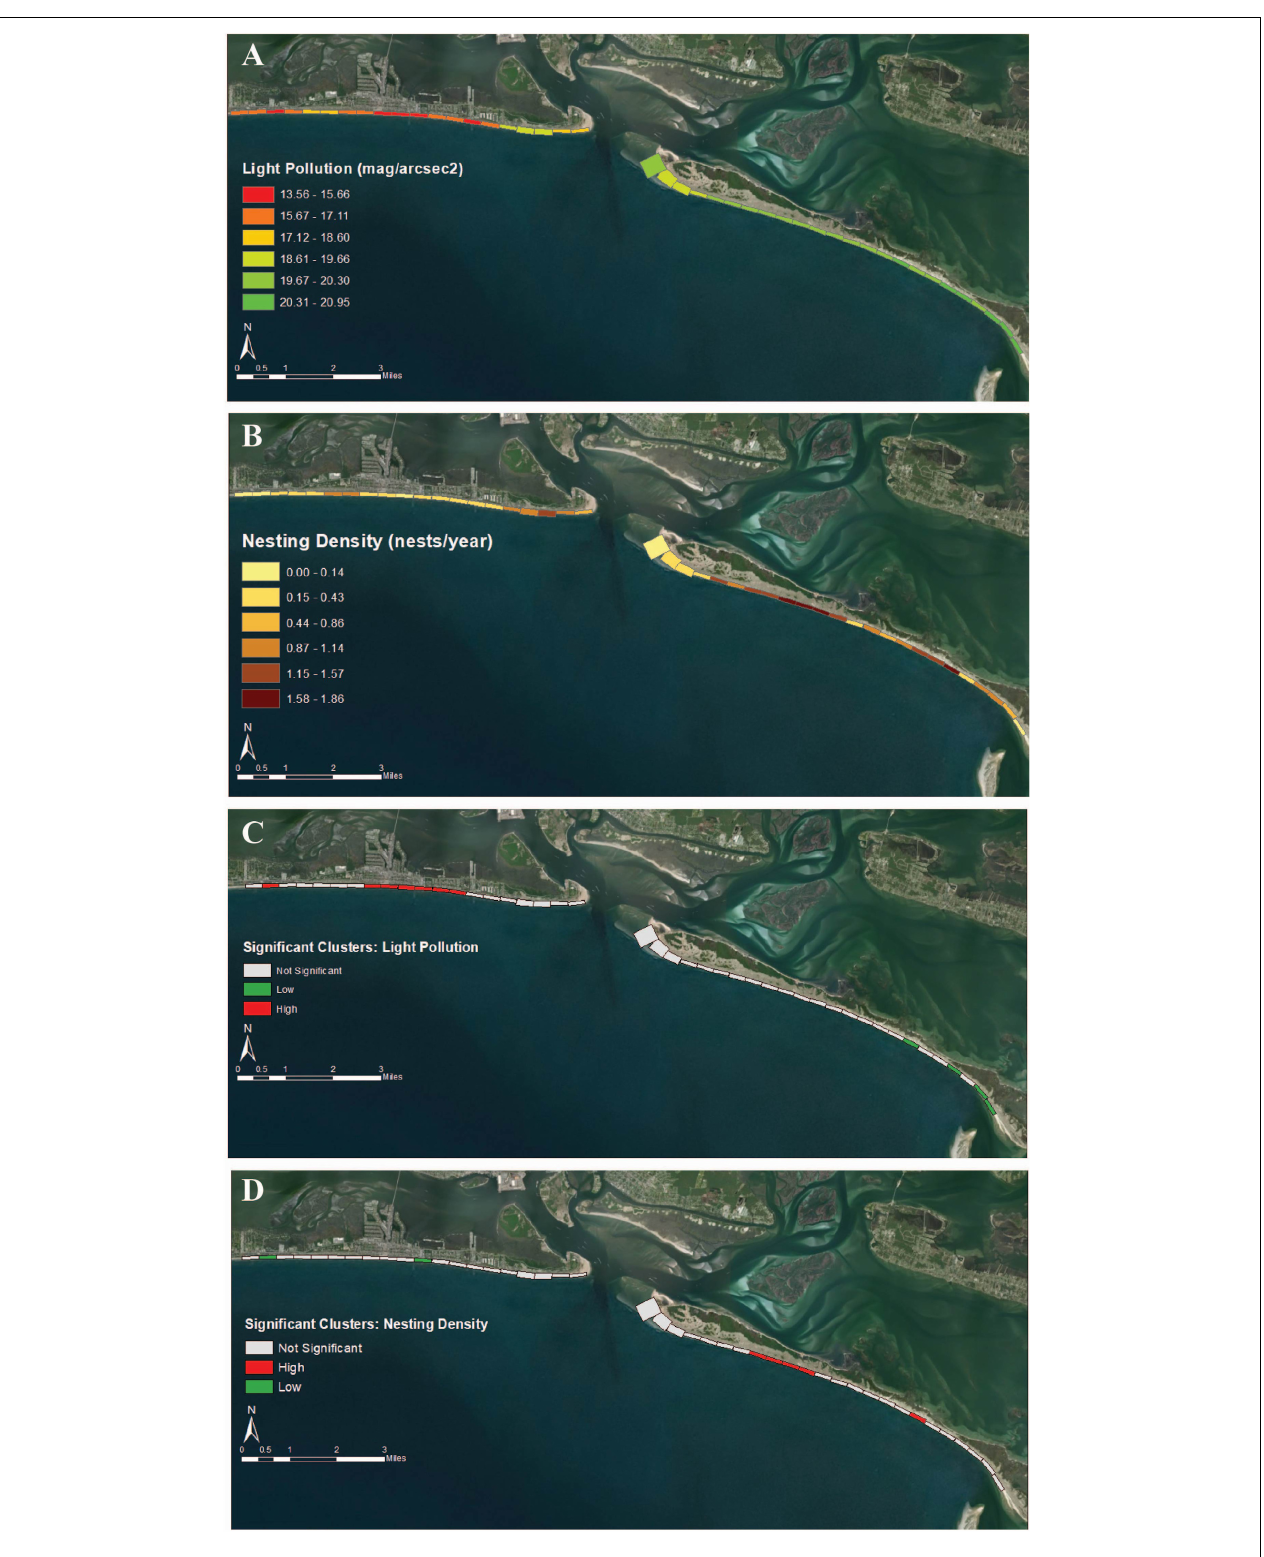
FIGURE 5 | (A) Mean light pollution value (mag/arcsec 2 ) in 500-m bins along study sites. (B) Nesting density (nests/year) from 2011 to 2017 in 500-m bin along study sites. (C) Cluster and Outlier Analysis (Anselin Moran’s I) portraying regions of significantly high light pollution in red and low light pollution in green and (D) significantly high nesting density in red and low nesting density in